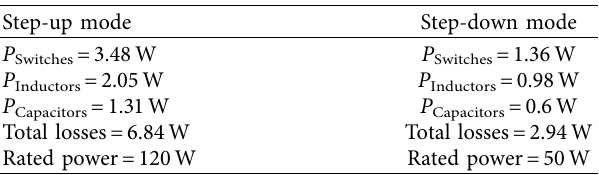
Figure 16: Measured efciency. Table 3: Power loss specifcation in the step-up and step-down modes based on efciency